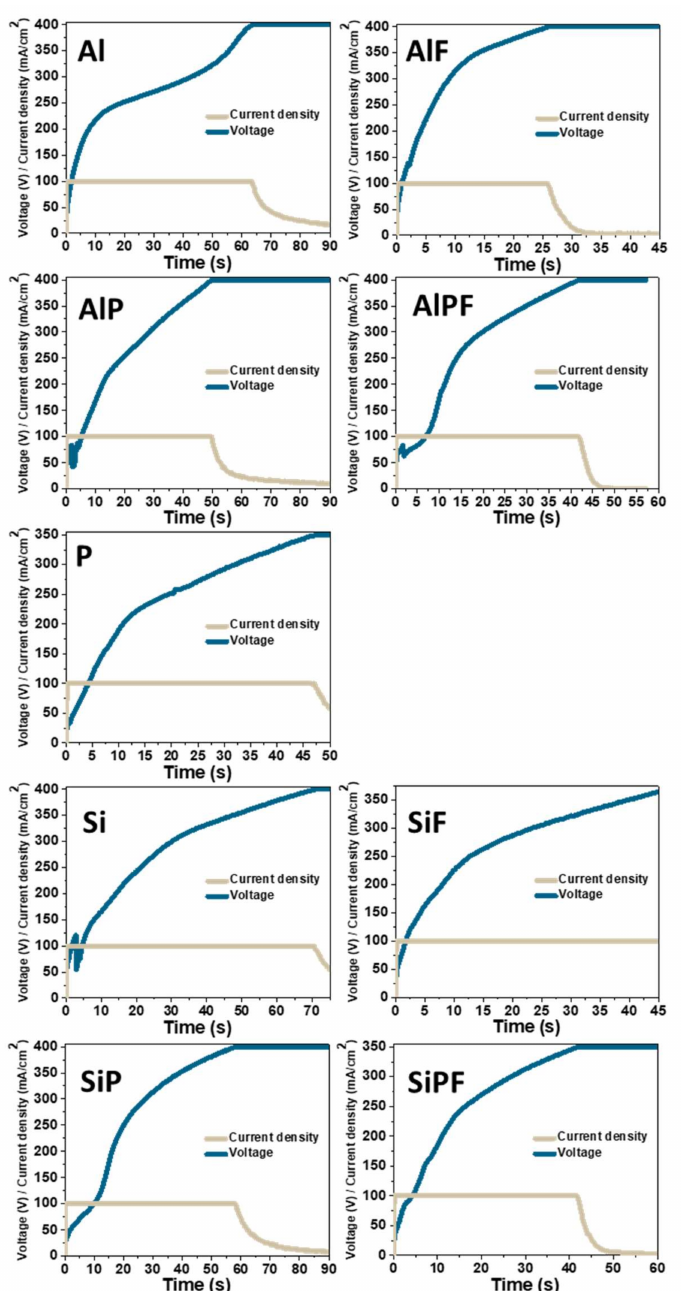
Figure 1. Current density/voltage–time curves registered during PEO processes in varied elec-